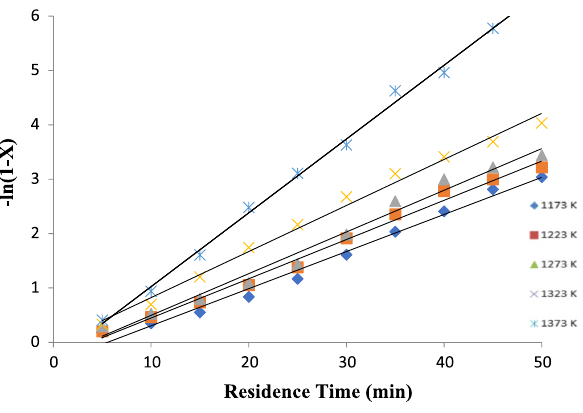
Fig. 3 Graph of −ln(1− X ) versus residence time for LWVC-I